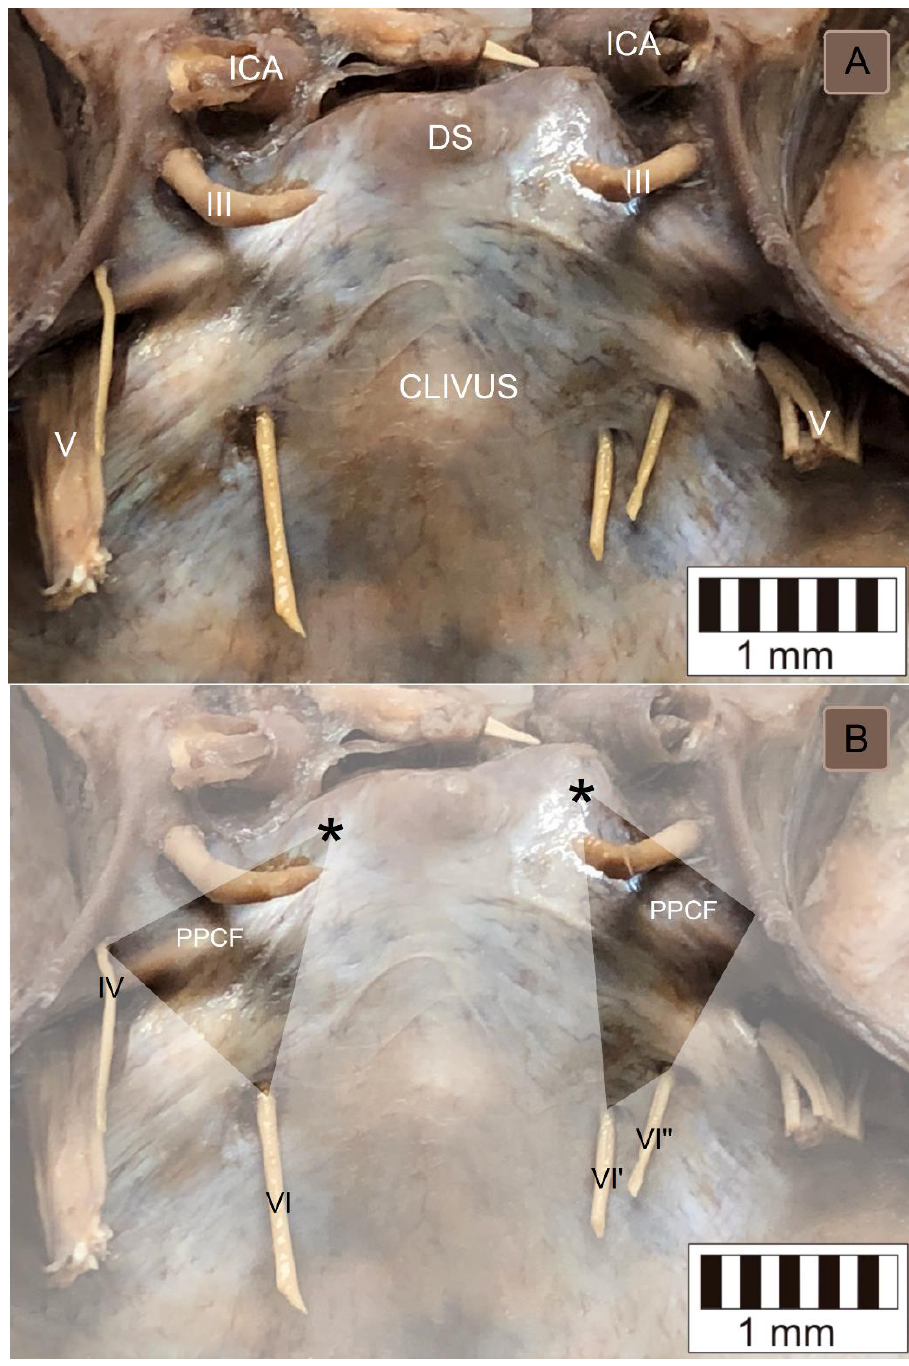
Figure 3. Posterosuperior view to the clivus and paraclival area. ( A ) Wet anatomical specimen. III = oculomotor nerve; V = trigeminal nerve; DS = dorsum sellae; and ICA = internal carotid artery. ( B ) The same photograph with the borders of the inferomedial paraclival triangle marked. On the left side, the anatomical relationships are typical; the triangle is delineated by the single abducens nerve (VI) dural entry point, the dural entrance of the trochlear nerve (IV) and the posterior clinoid process (marked by a black asterisk). Note the different positions (asymmetry) of the posterior clinoid processes on both sides. On the right side, the duplication of the abducens nerve is revealed. In this variant, the two nerve trunks (VI′ and VI″) enter the cavernous sinus posterior wall via two separate dural entry points. On this side, the inferomedial triangle is replaced by a trapezoid-shaped area.